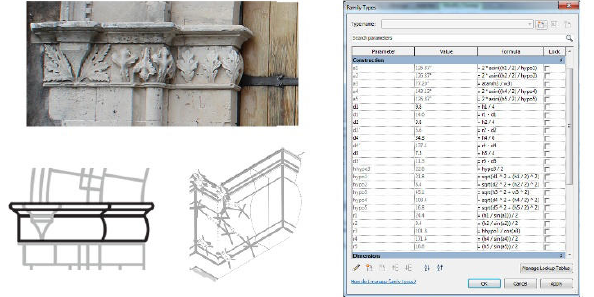
Figure 8. Springer cornice of S. Antonio Abate church (Mascalucia). From the picture to the 2D and 3D representation, up to the complete geometric control through the insertion of parametric